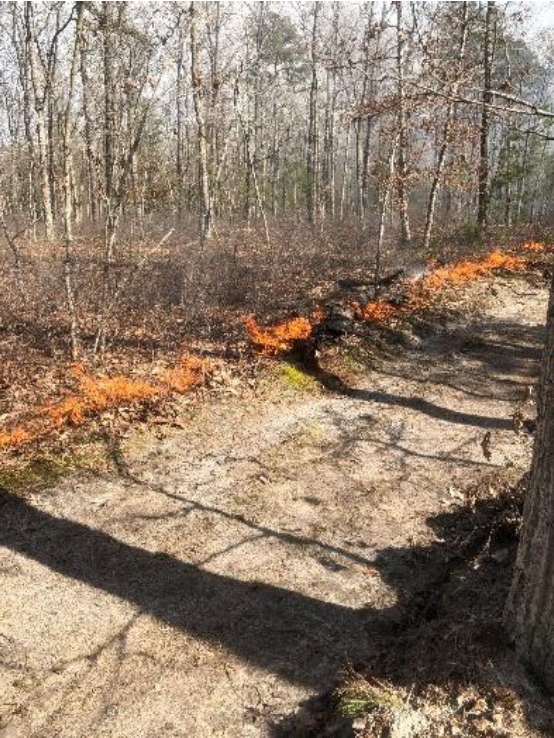
Figure 3. Photograph of the surface line fire ignited along the southwest side of burn unit.